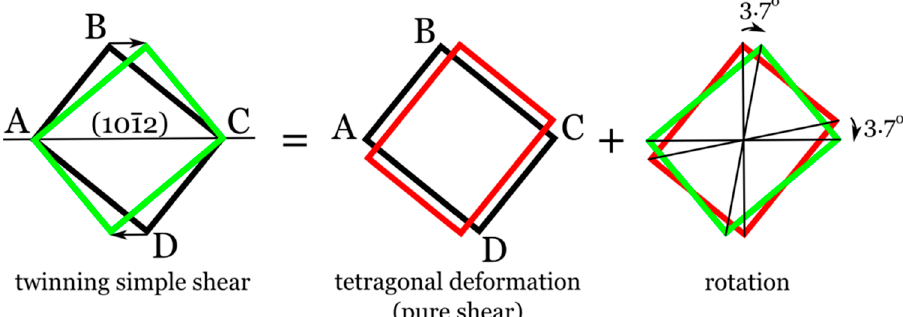
Figure 11. Scheme of interrelation between twinning simple shear on {1012} plane and basal-prismatic tetragonal deformation (from [71]). Black rectangle ABCD is the projection of hcp unit cell in < a > direction (AB is the trace of basal plane and BC is the trace of prismatic plane). Due to twinning shear on {1012} plane, the black rectangle is deformed into green one. Basal-prismatic tetragonal deformation deforms black rectangle to the red one. Red and green rectangles have the same shape, but di ff erent orientation (Reproduced from [71] under terms of Creative Commons Attribution 3.0 licence).